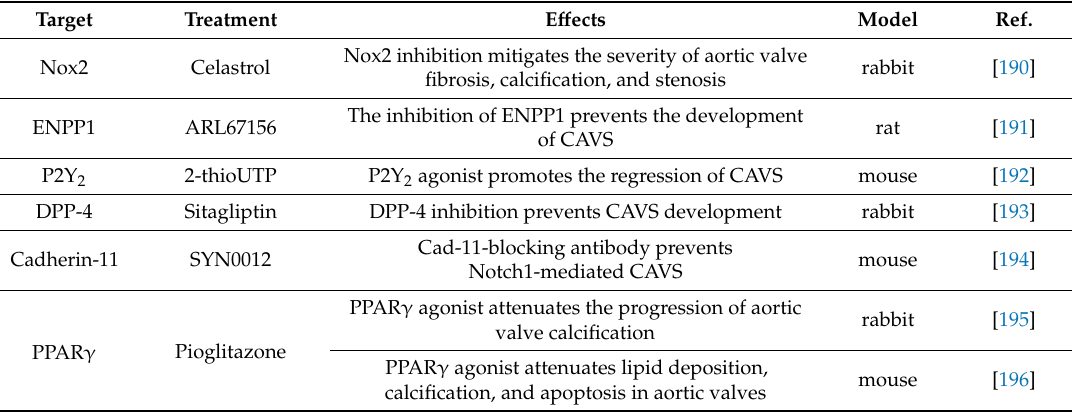
Figure 2. A simplified schematic representation of potential novel targets (in black) and corresponding treatments (in red). The regular arrow means “activation”, the T-shaped arrow stands for “inhibition”. Table 2. Potential novel targets for CAVS and corresponding treatments with in vivo